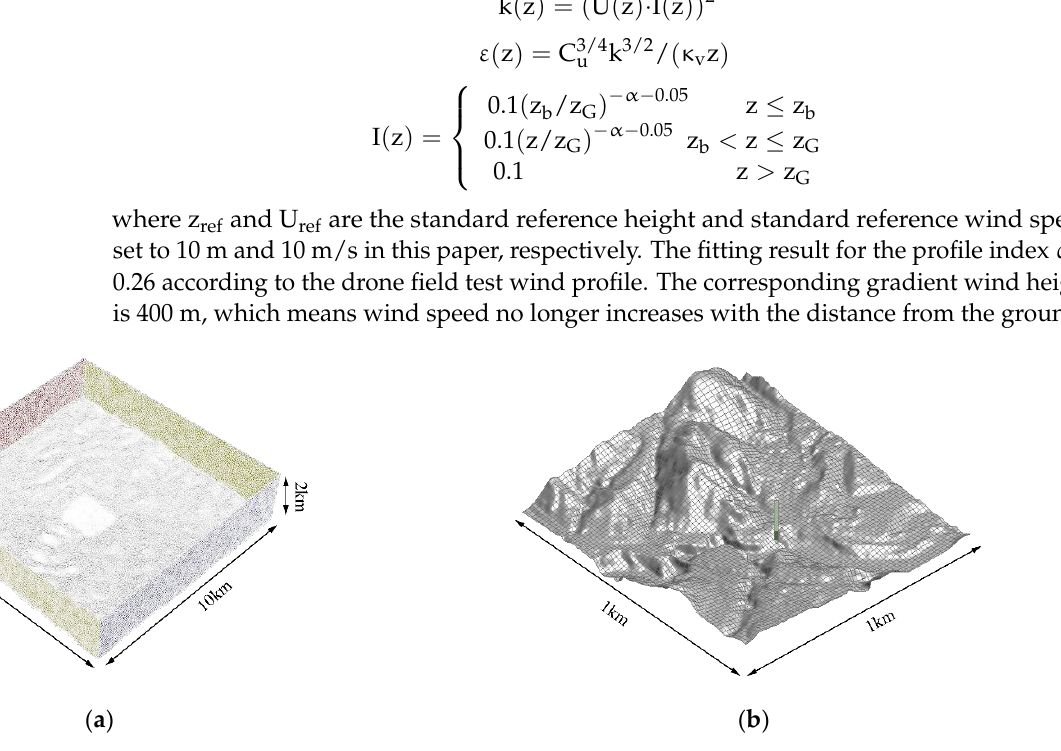
Figure 8. Computational domain ( a ) higher-level domain. ( b ) current-level domain.